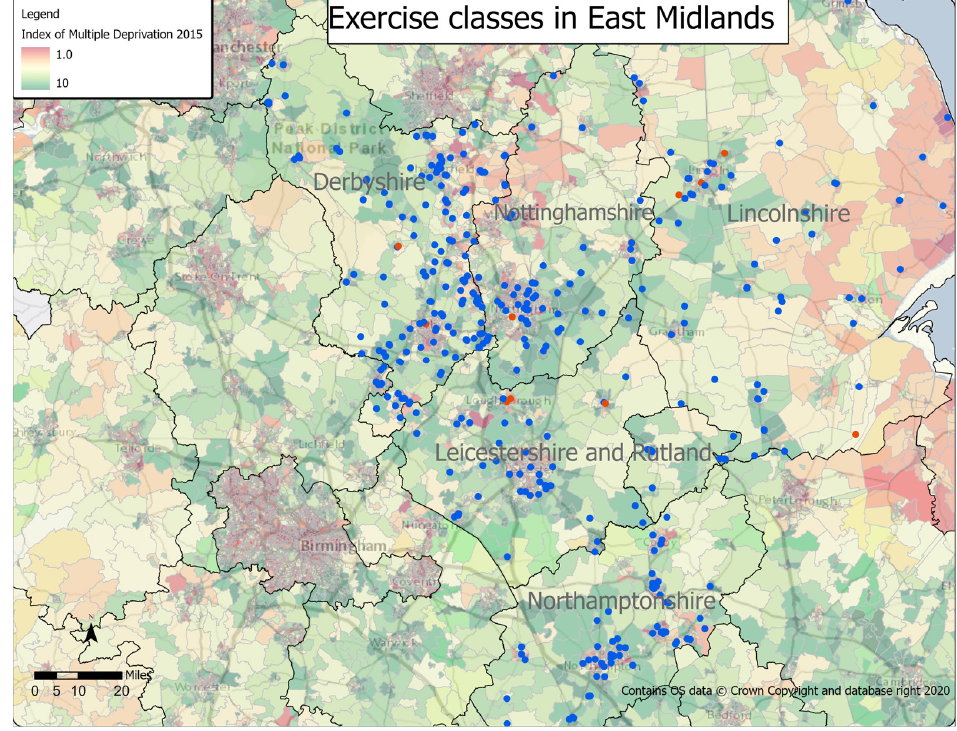
Figure 3. Location of exercise classes in East Midlands, overlaid with the Index of Multiple Deprivation. Derbyshire had a mixture of areas of both high deprivation (1.0) and low deprivation (10), and classes were well distributed in all areas, ranging from nine classes in the highest areas of deprivation to 15 classes in the lowest areas. Overall, 94 (45%) classes were in areas which were rated from 1–5 on the Index of Multiple Deprivation, with 115 (55%) located in areas rated from